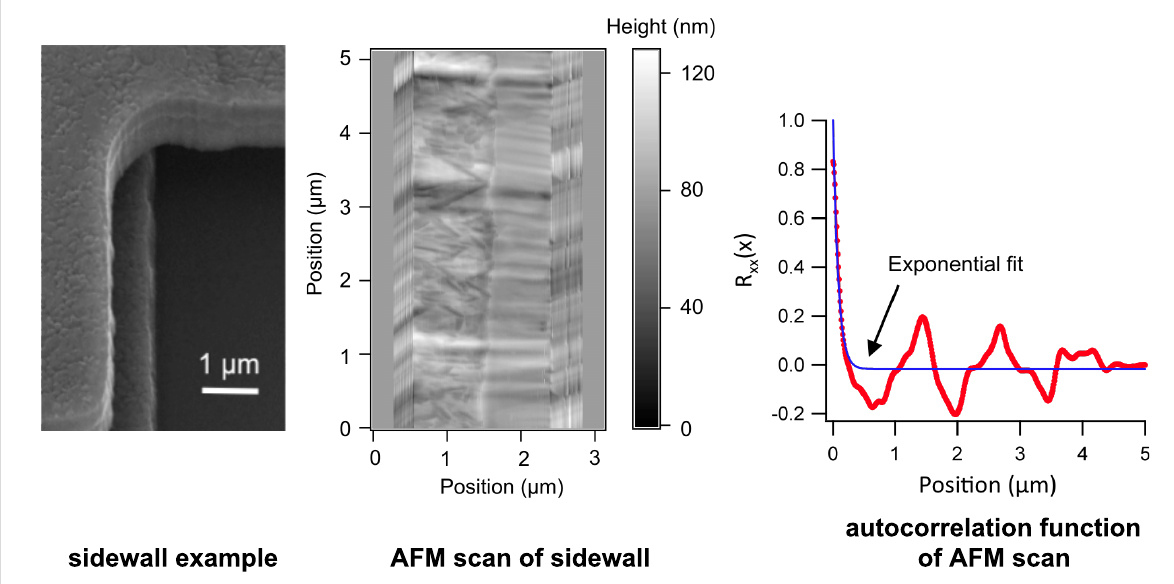
Figure 6: Autocorrelation function R xx ( x ) of a pristine sidewall surface measured with AFM, and theoretical exponential fit with a correlation length of 83 nm. The standard deviation on the height is 10.3 nm and the distribution is almost Gaussian. The long-range order is caused by the larger scale ripples. The result is that only one ripple may stick out significantly more than the others and hence friction is more localised than on a surface with a purely exponentially decreasing autocorrelation function. The sidewall measured with AFM is similar but not identical to the one used for the friction